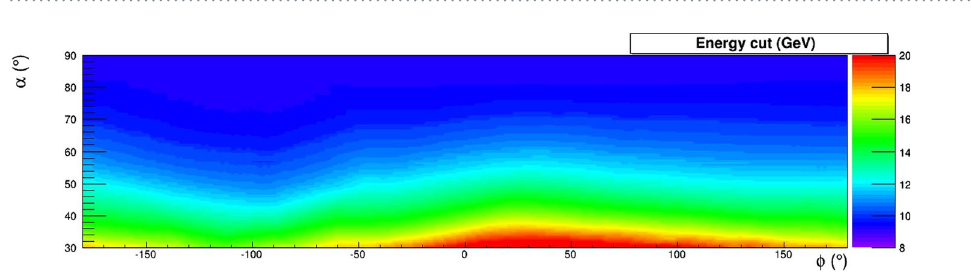
Figure 12. Minimum energy ρ α φ E ( , , ) required for a muon to cross the rock overburden, whose thickness min is shown in Fig. 11, evaluated for an uniform average rock density ρ = 1.4 g/cm 3 . The drawing was obtained using the software root